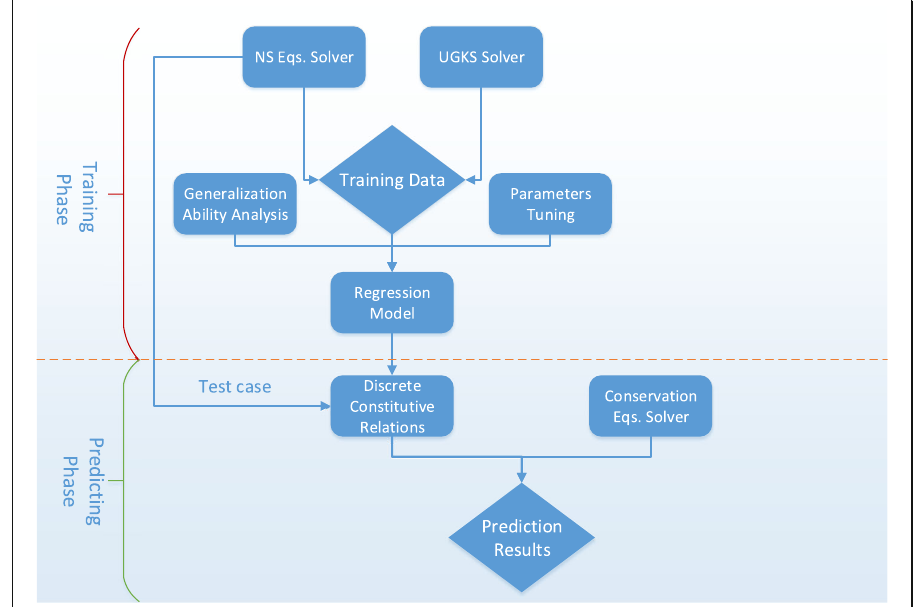
Fig. 1 Flow diagram of DNCR